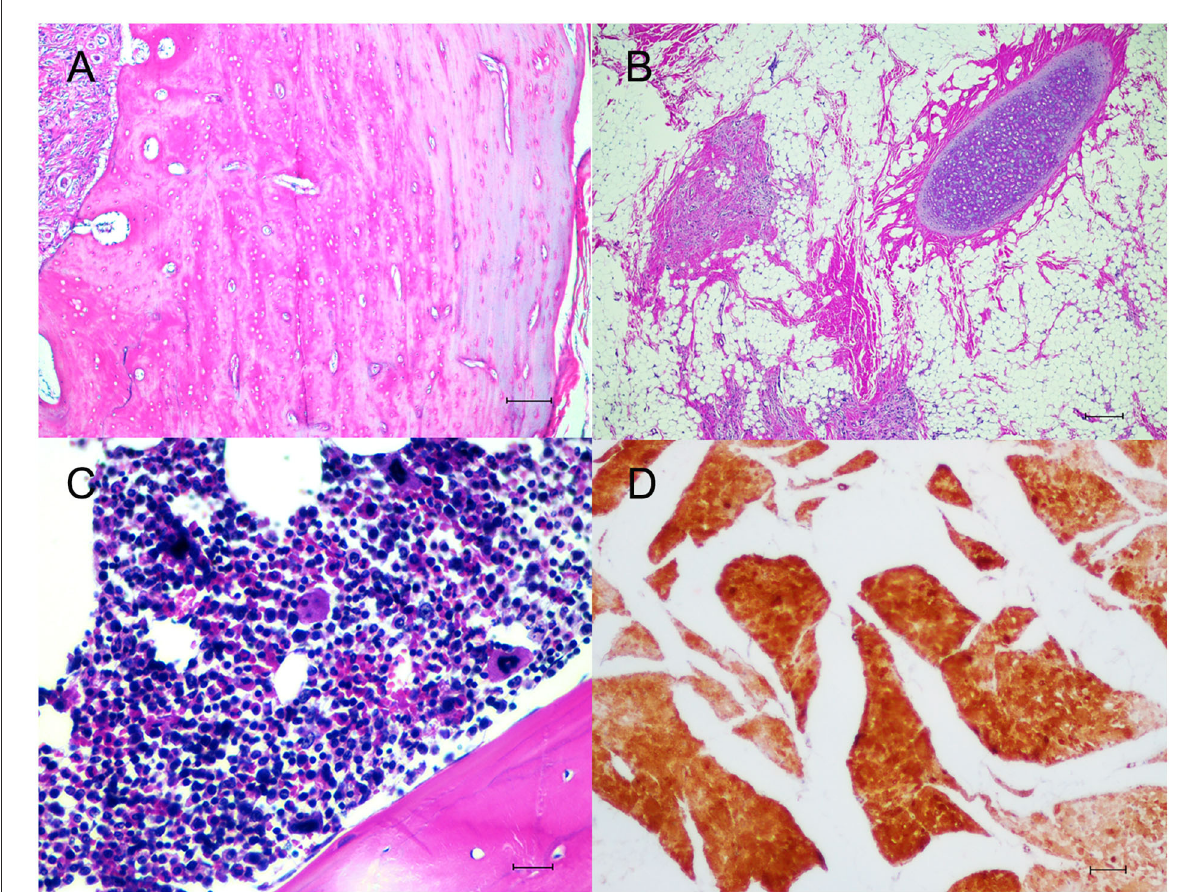
FIGURE3 Microscopic findings of mesodermal components. (A,B) The mesodermal tissue consisted of cartilages, adipocytes, smooth muscles and bony trabeculae. H&E. Bar = 100 µ m. (C) The proximal margin contained pools of hematopoietic cells. H&E. Bar = 50 µ m. (D) Smooth muscles were highlighted with alpha smooth muscle actin. IHC. Bar = 100 µ